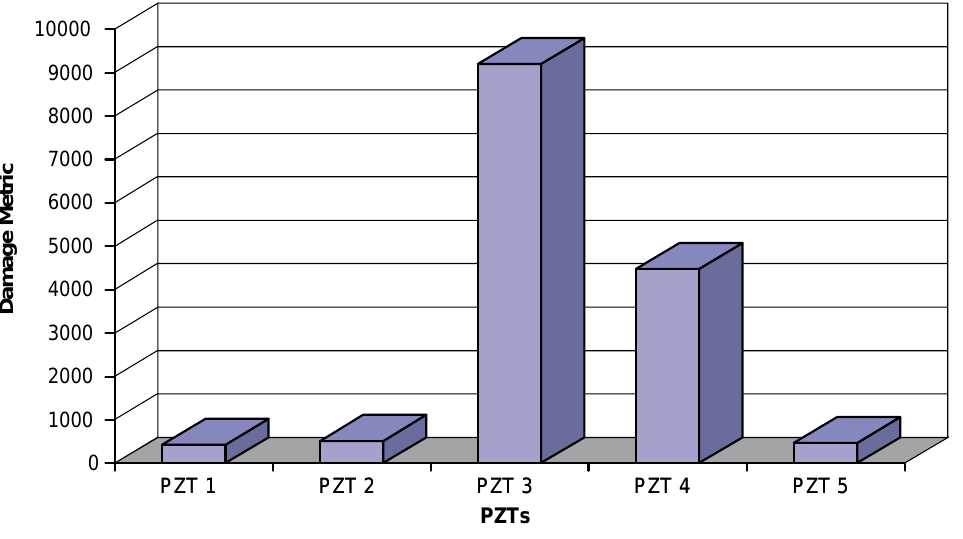
Fig. 3. Damage metric chart. The significant change in PZT 3 and 4 indicates the damage between the two